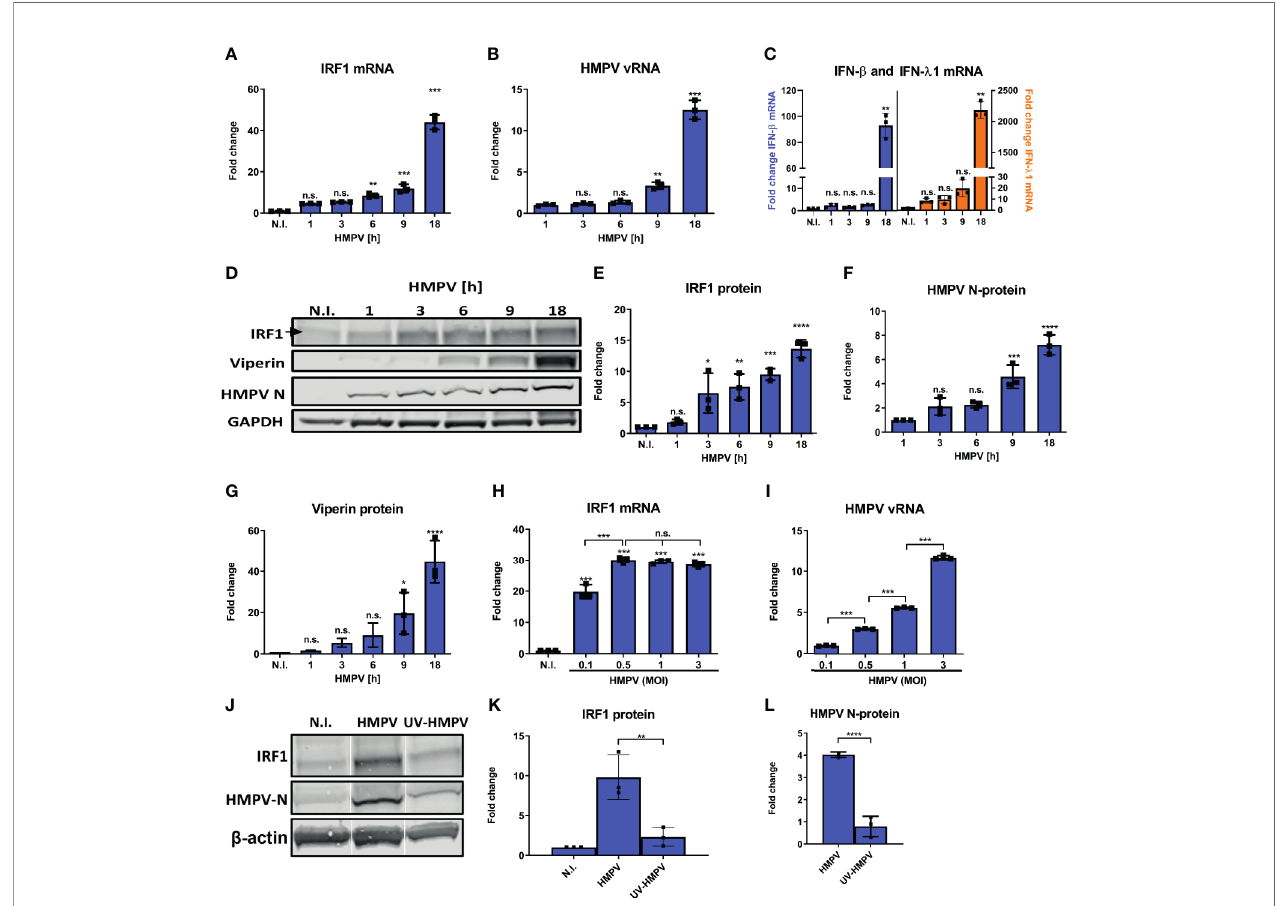
FIGURE 1 | HMPV induces IRF1 expression from early timepoints of infection. (A – G) Human MDMs were infected for the indicated timepoints with HMPV or treated with medium (N.I.). Expression of IRF1 mRNA (A) , HMPV vRNA (B) , IFN- b and IFN- l 1 mRNA (C) was analyzed by qRT-PCR. Error bars represent SD of three technical replicates. (D – G) Whole cell lysates were prepared and protein levels of IRF1 (E) , HMPV N-protein (F) and viperin (G) were analyzed by immunoblotting. Protein levels were quanti fi ed by normalization of band intensities against GAPDH and are presented as fold change relative to uninfected cells ( “ N.I. ” ). (H, I) Human MDMs were infected for 18 h with HMPV at the indicated MOI or treated with medium ( “ N.I. ” ). Expression of IRF1 mRNA (H) and HMPV vRNA (I) was analyzed by qRT-PCR. Error bars represent SD of three technical replicates. (J – L) Human MDMs were infected for 18 h with HMPV or UV-inactivated HMPV or treated with medium ( “ N.I. ” ). Expression of IRF1 (K) and HMPV N-protein (L) were determined by immunoblotting. Statistical analysis: One-way ANOVA followed by Tukey ’ s multiple comparison test: ∗ p < 0.05; ∗∗ p < 0.01; ∗∗∗ p < 0.001; ∗∗∗∗ p < 0.0001; n.s., not signi fi